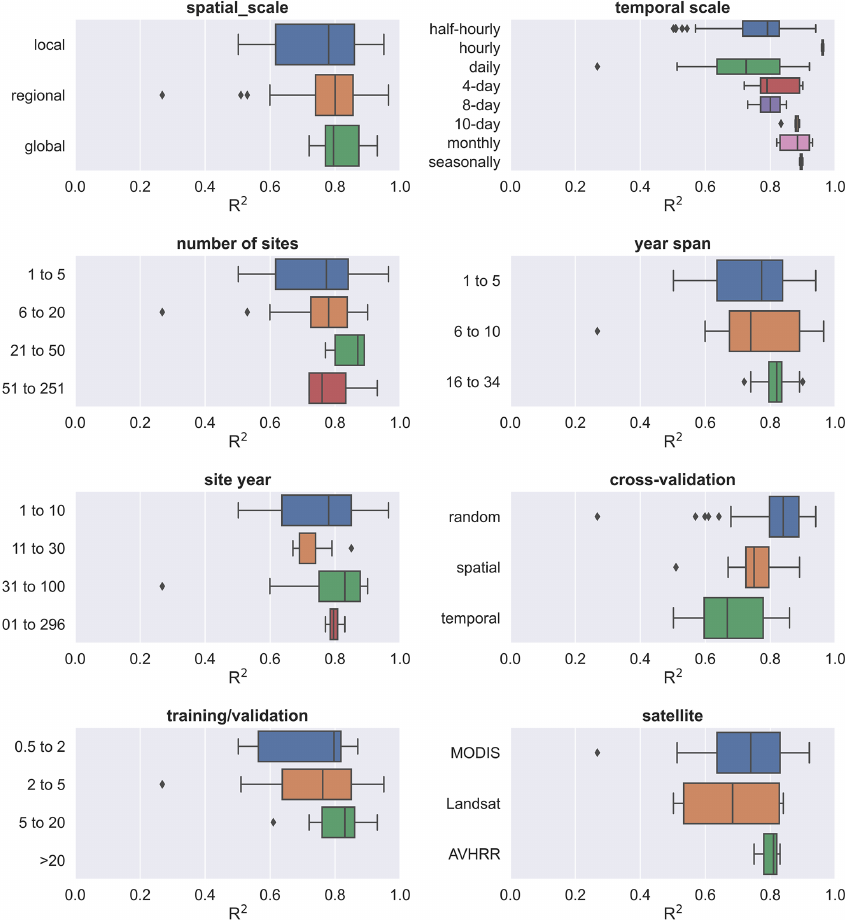
Figure 6. The effects of other model features (i.e., spatial scale, number of sites, temporal scale, year span, site year, validation method, training / validation ratio, and satellite imagery used) on the R